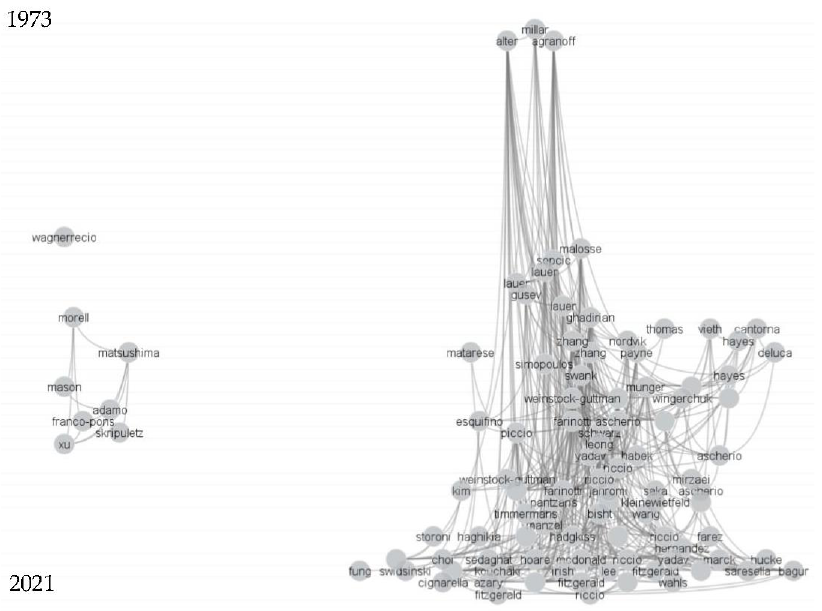
Figure 1. Citation networks of 100 most cited articles among all articles exported from Web of Sci- ence Core Collection. Core